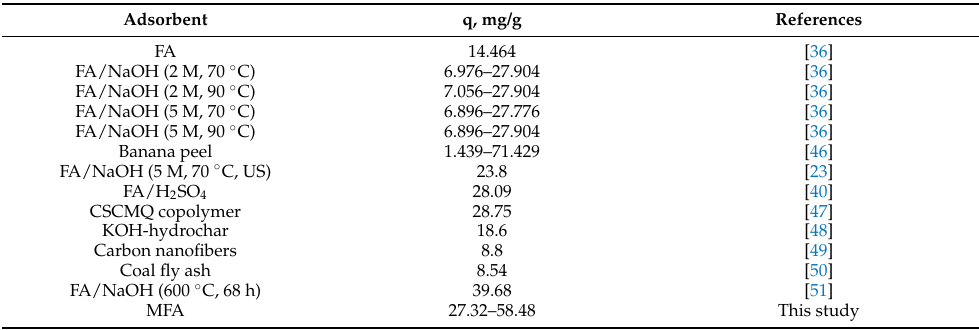
Table 6. Comparison of the adsorption capacities for different adsorbents for Cu(II) adsorption. Adsorbent q,